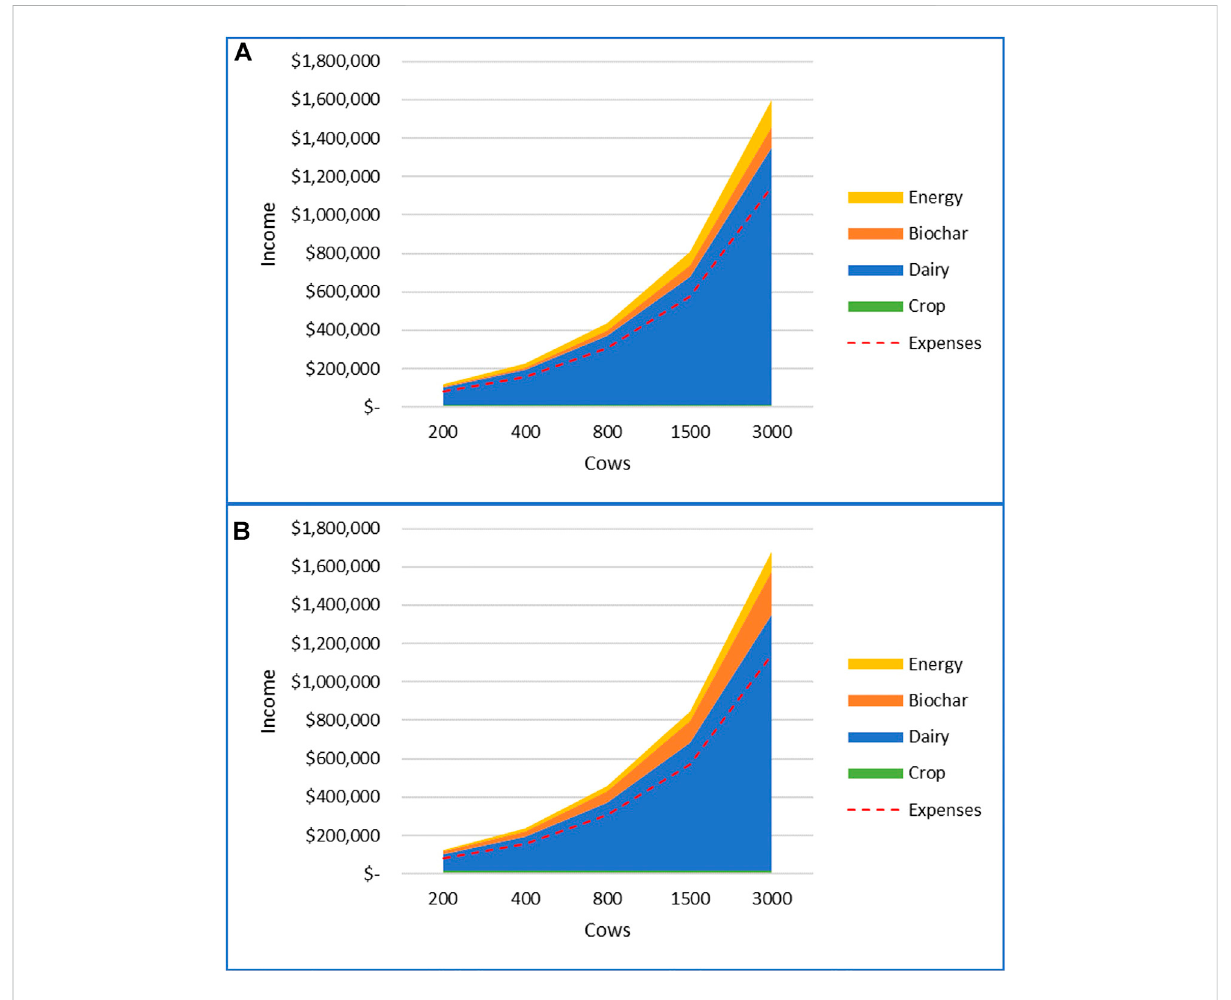
FIGURE 5 Components of monthly income using gasi fi cation (A) and pyrolysis (B)